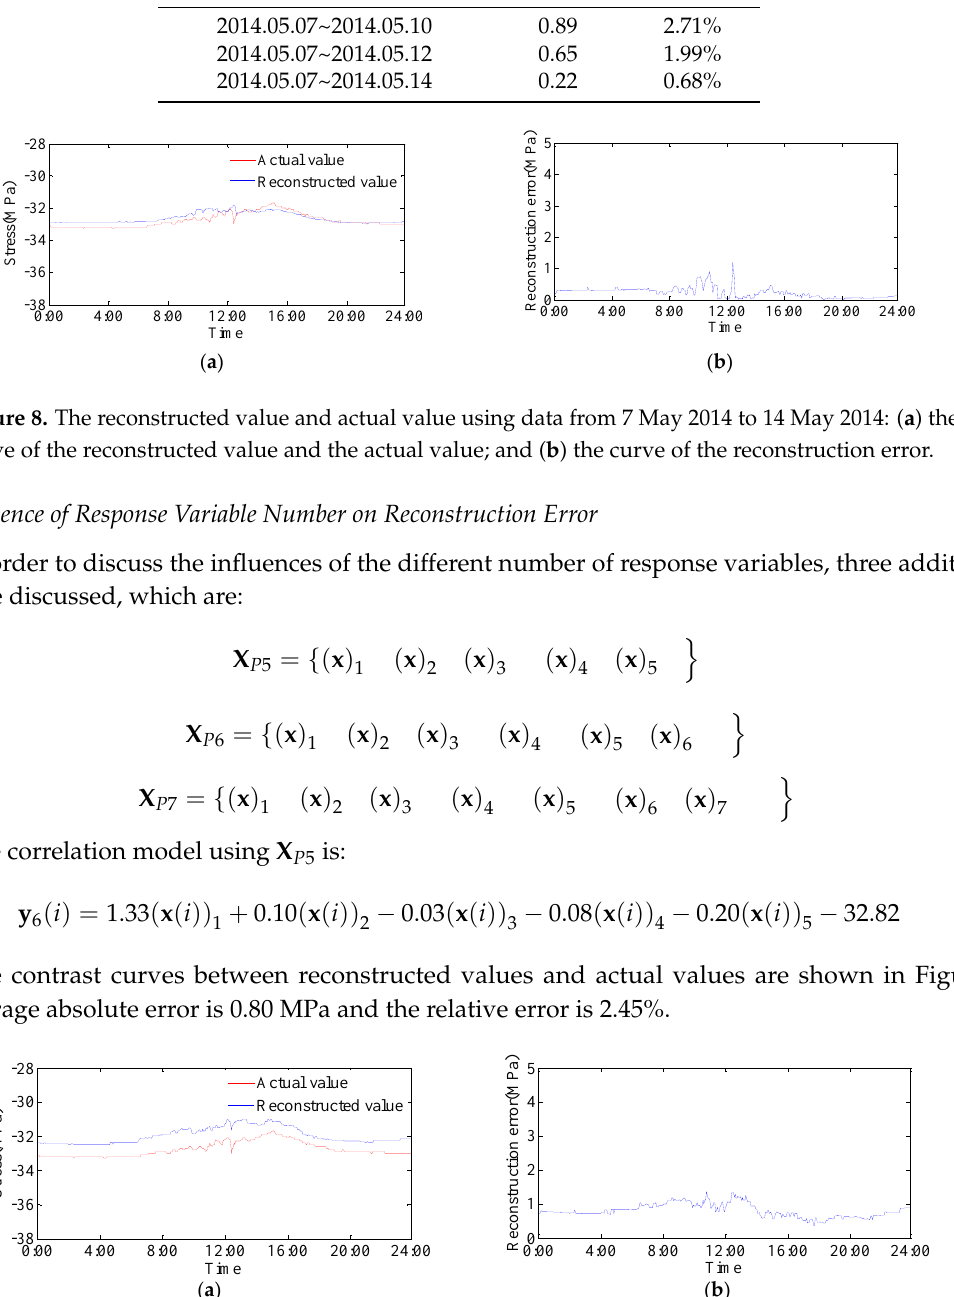
The contrast curves between the reconstructed values and the actual values are shown in Figure 8. Table 3. The summarized errors using stress monitoring data from different time periods. The average absolute error is 0.22 MPa and the relative error is 0.68%.